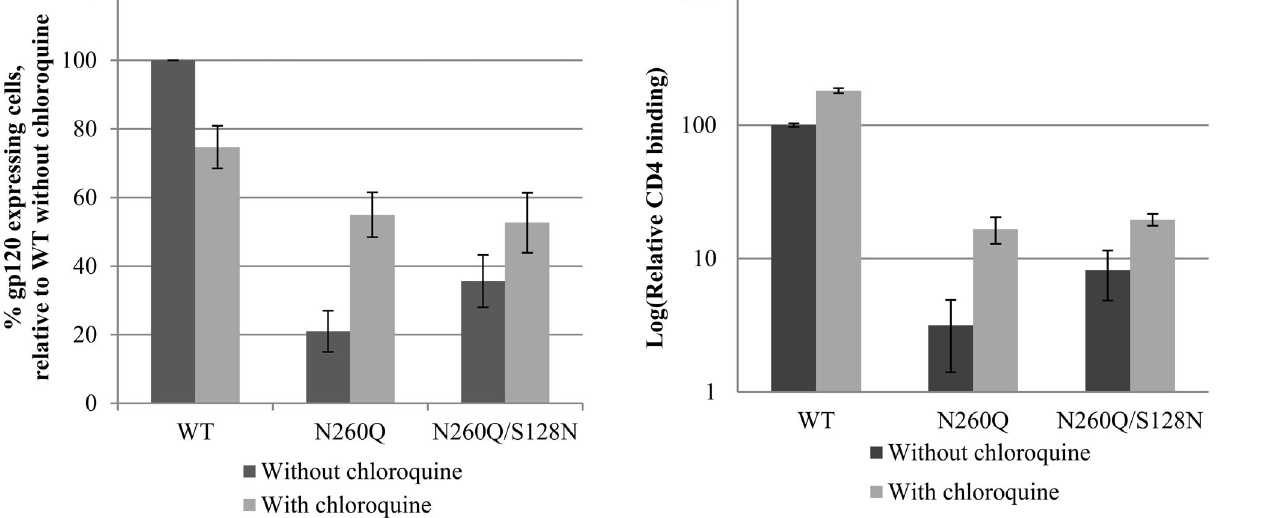
Figure 9. Flow cytometric analysis of gp120 expression on the surface of HIV-transfected HEK293T cells, in the absence or presence of chloroquine. Two days after transfection in the absence or presence of chloroquine to produce WT, N260Q or N260Q/S128N virus, HEK293T cells were stained to detect gp120 on the cell surface with the primary antibody 2G12 and a secondary anti-human antibody labelled with Alexa Fluor 647. Data are the means ( 6 SEM) of 5 independent experiments.